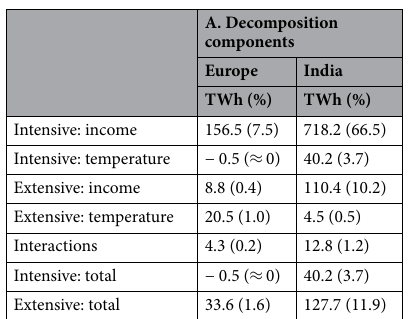
Figure 4. Decomposition of changes in total annual electricity demand in 2050 relative to present. Demand amplification at the climate-driven intensive margin and the climate and income-driven extensive margin components (coloured bars)—median of 29 GCMs. The circles represent the additional total annual load increase due to the change in future per capita income, and are hence unrelated to cooling (income effect).